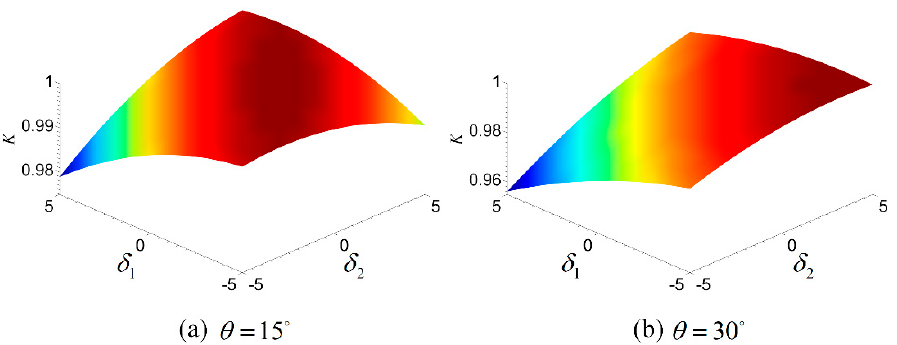
Figure 4. Contrast loss caused by polarization angle deviation at different incident angles. The larger the incident angle, the more unstable the interference system. For ( a ), the incident angle is 15°. For ( b ), the incident angle is 30°.